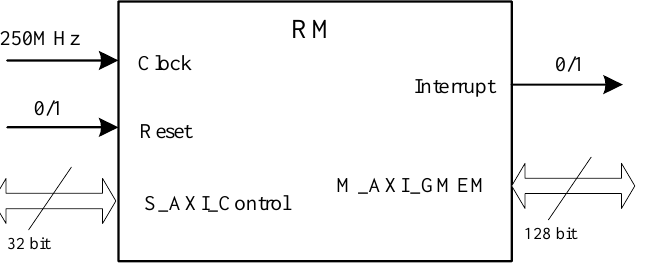
Figure 4. Top-level design interface specification of the single reconfigurable module group.